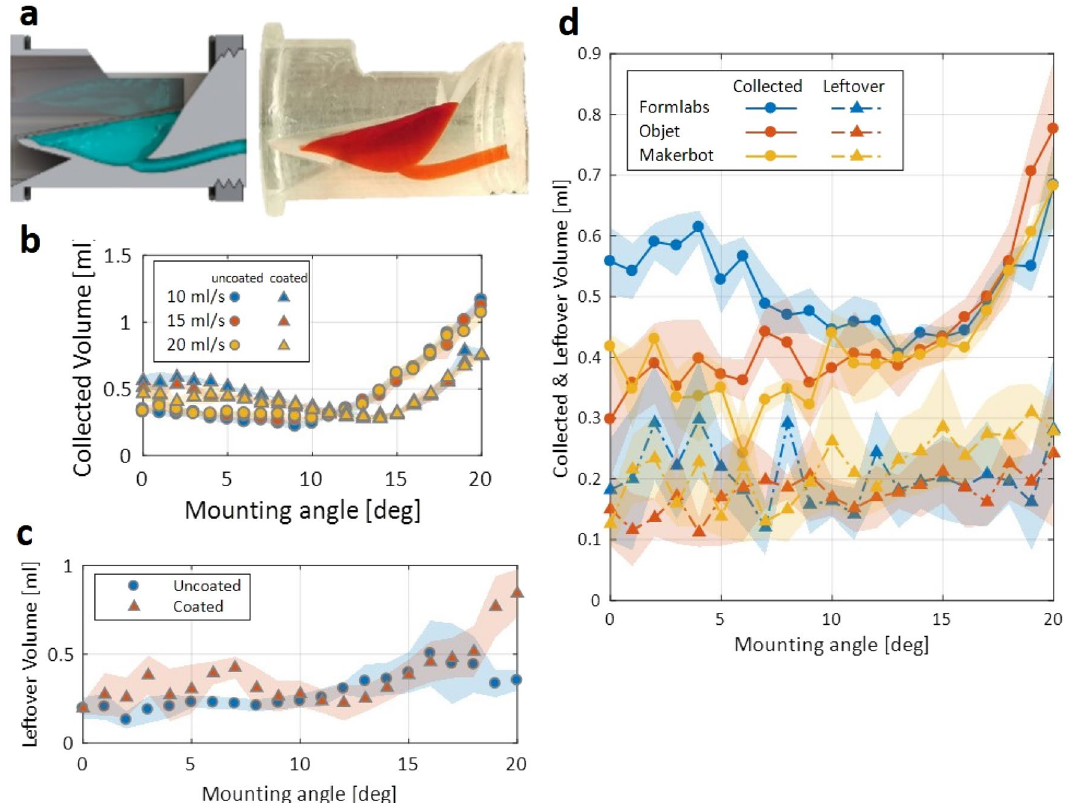
Figure 2. Characterization of the collected sample volume and leftover volume for the collector design. ( a ) Cross-sectional view of the collector design is provided (computer model, left, and photograph, right) ( b ) The amount of sample collected (mL) versus mounting angle (°) (n = 5). ( c ) The amount of leftover liquid after flushing. ( d ) The collected and leftover sample volumes for the collector fabricated by three different printers (Formlabs Form 2, Objet30 Prime, and Makerbot